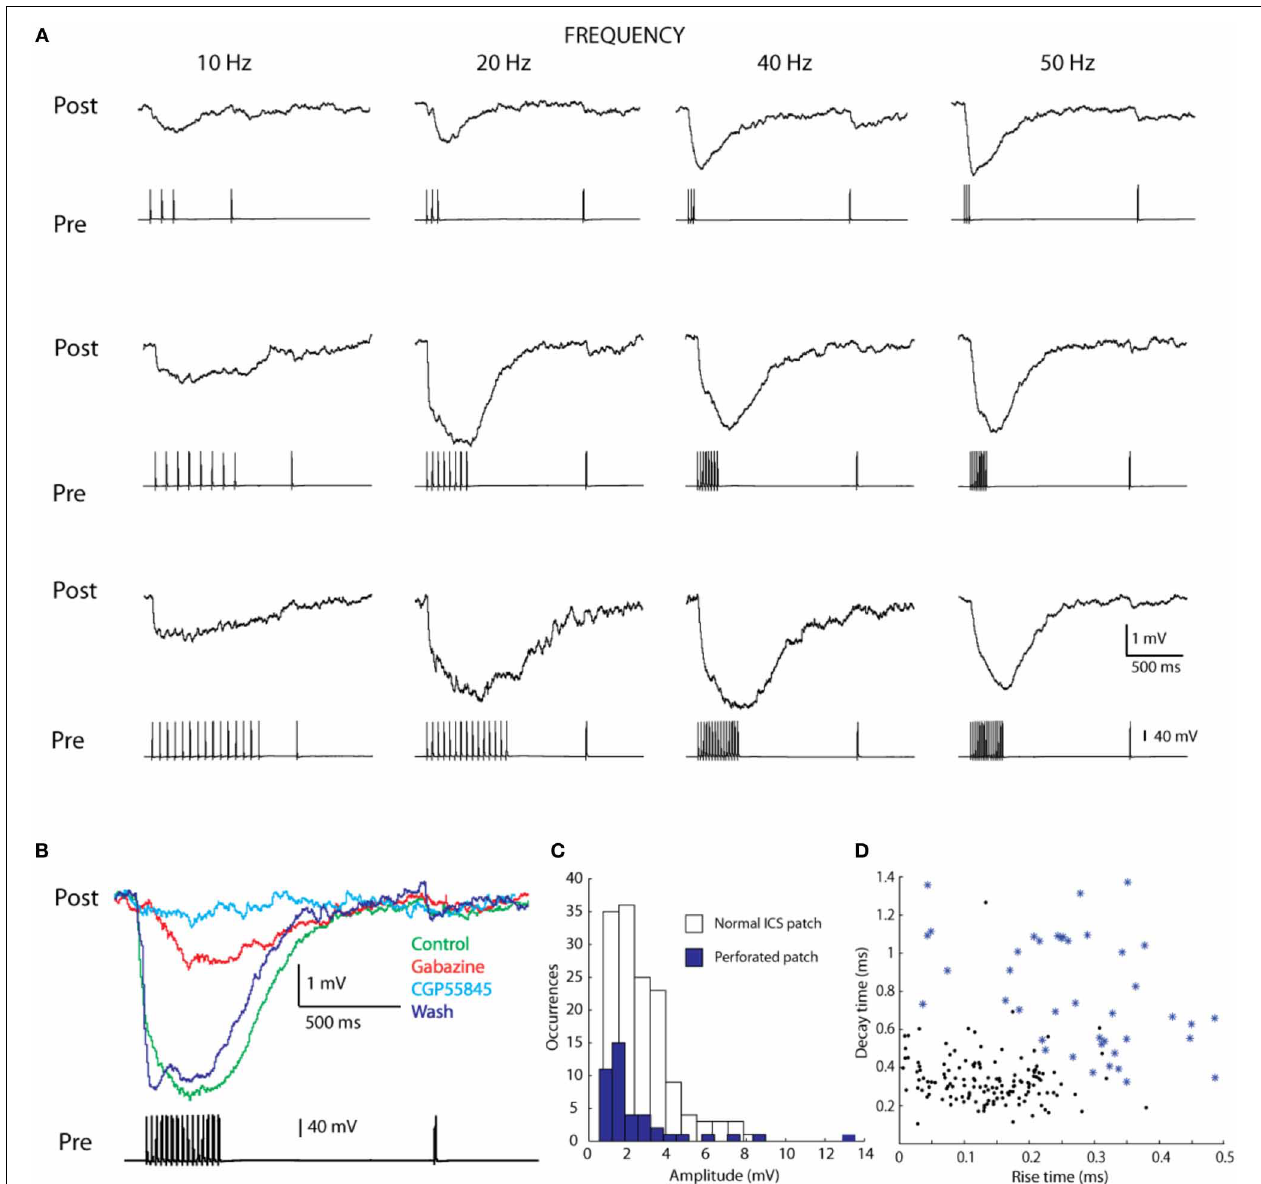
FIGURE 6 | Perforated patch of L1 cells. (A) A frequency analyses of the synaptic connection performed with perforated patch, examples showing variation in spike number (3, 8, and 15) and frequency (10, 20, 40, 50Hz) (B) pharmacology performed with Gabazine (GABA A blocker) and CGP55845